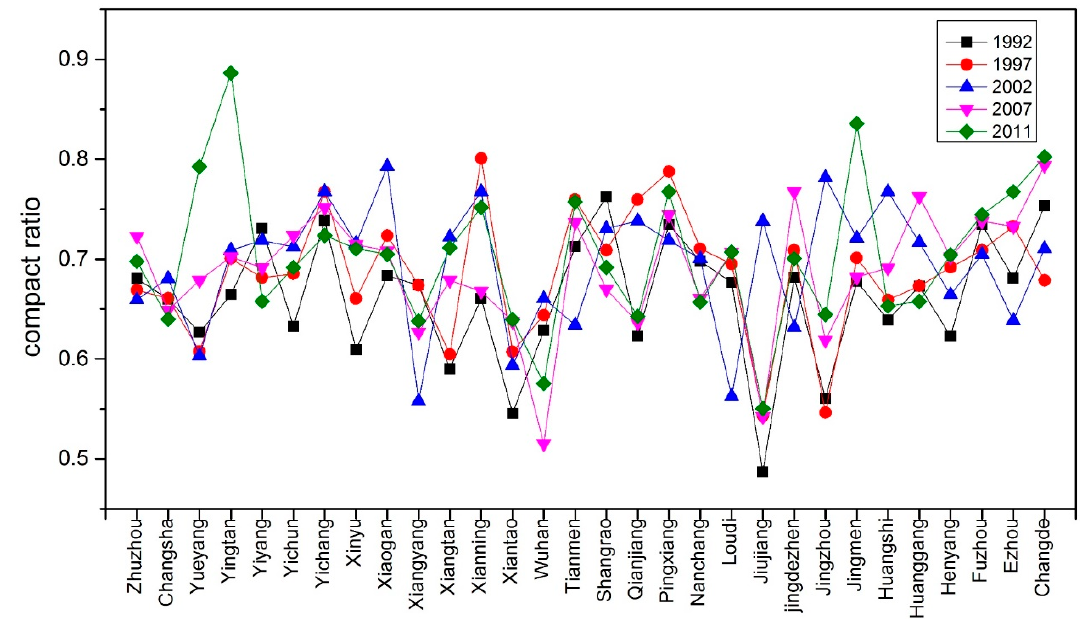
Figure 11. Compactness ratio of each city at different times. Table 3. Fractal dimension of the urban boundary of each city in 1992, 1997, 2002, 2007, and 2011.